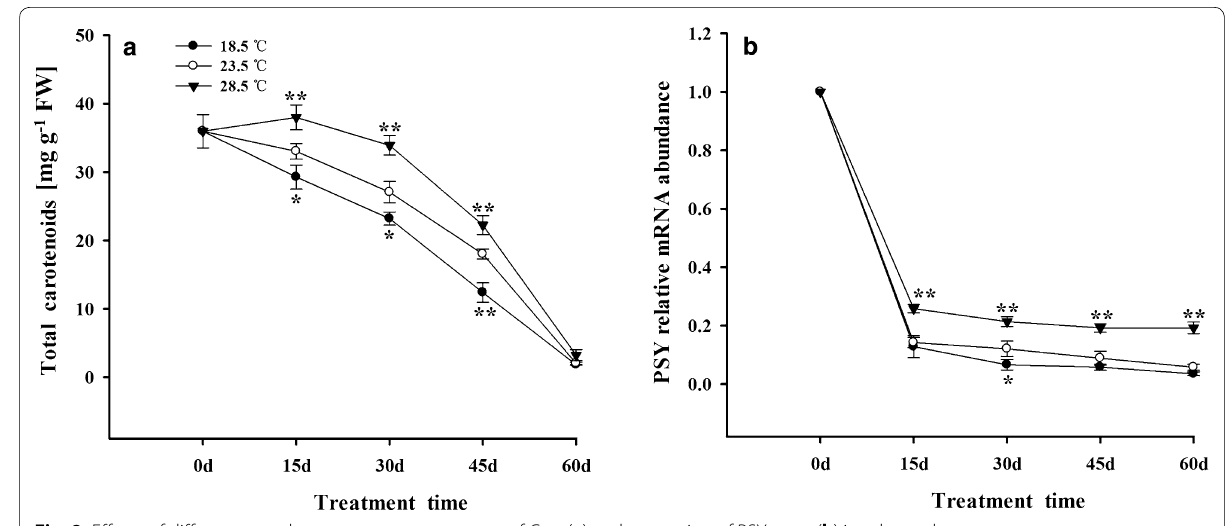
Fig. 8 Effects of different growth temperatures on content of Cars ( a ) and expression of PSY gene ( b ) in tobacco